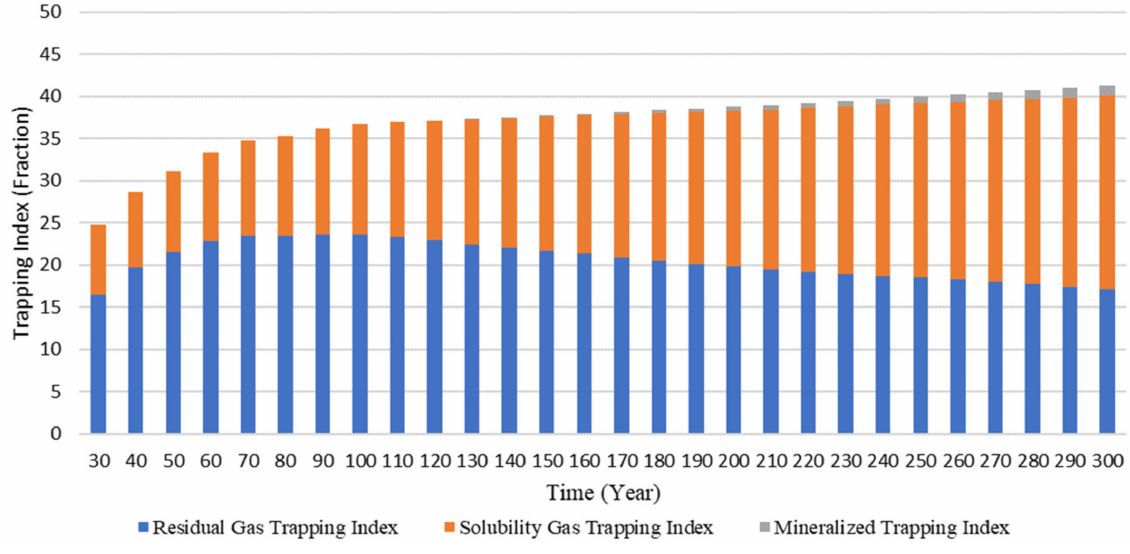
Figure 6. Change in trapping index over